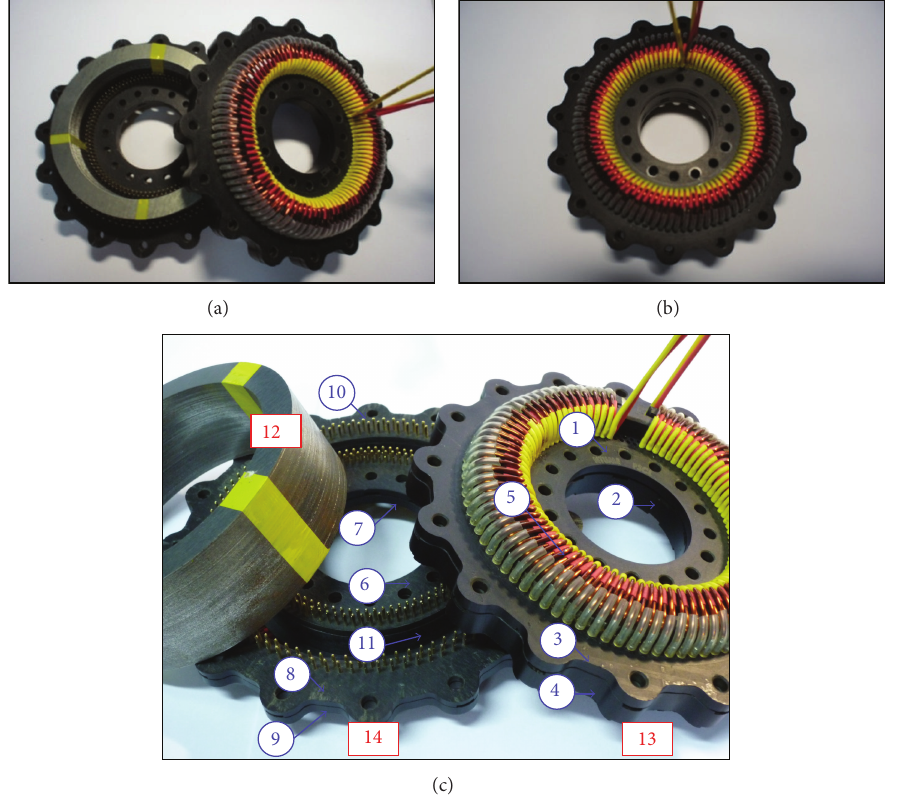
Figure 7: Innovative structure of the new toroidal frame. (a) Standardized toroidal frame and ring specimens. (b) Implementation of the novel structure. (c) Overview of the components of the innovative detachable standardized toroidal test frame.